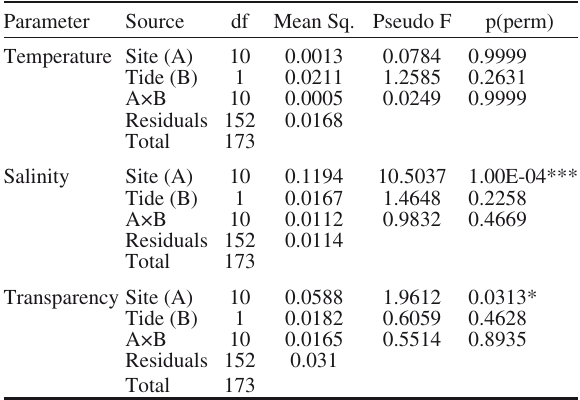
Table 1. – Summary results from the two-way PERMANOVA test- ing for differences in water temperature, salinity and transparency by sites, tides and their interaction. Mean Sq., mean square; df, de- grees of freedom. * p<0.05, *** p<0.001.